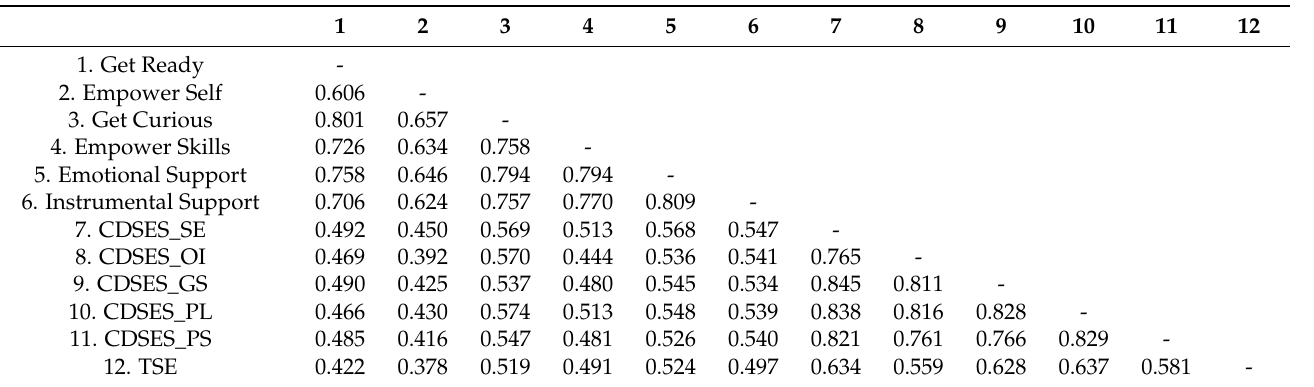
Table 3. Correlations between the TCSSE dimensions, career decision self-efficacy dimensions and teacher